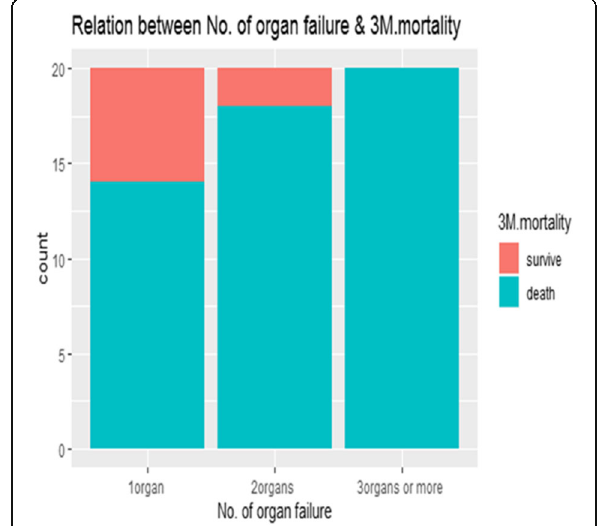
Fig. 4 Relation between no. of organ failure 3M. mortality. Figures 3 and 4 show that there is a significant difference between no. of organ failure and both 1M. and 3M.